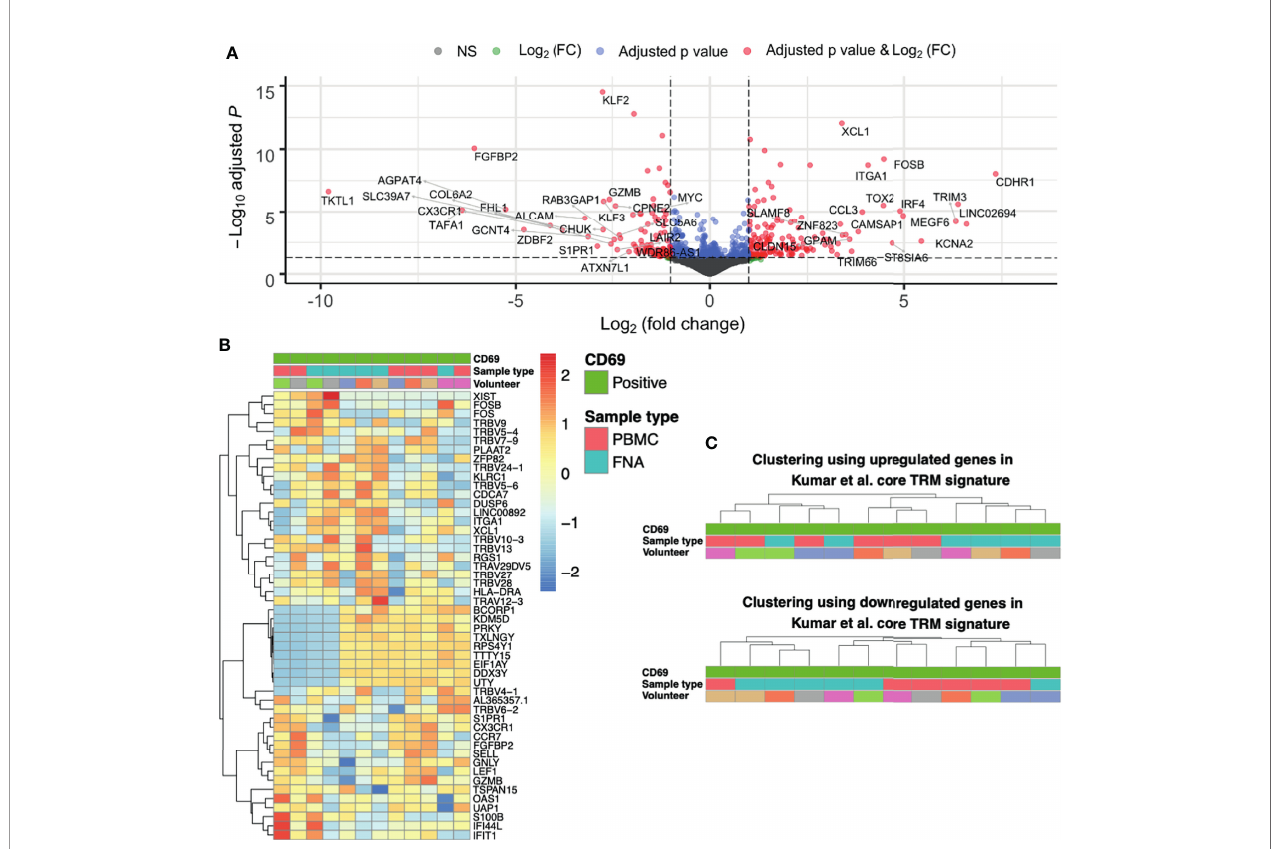
FIGURE 3 | The differences between CD69+ CD8+ T cells isolated from liver and blood are unique and not like those when comparing TRM and TEM cells. (A) Volcano plot of up- and down-regulated genes between paired FNA CD69+ and PBMC CD69+ samples. The top 50 up- and down-regulated genes have been annotated. Positive log(FC) values indicate greater gene expression in FNA CD69+ samples, compared to PBMC CD69+ samples. Negative log(FC) values indicate greater gene expression in PBMC CD69+ samples. DGE of 11,933 genes was tested for signi fi cance using the Wald test. P values were adjusted using the Benjamini-Hochberg correction (false discovery rate). (B) Heatmap of the most variable genes in the FNA CD69+ vs PBMC CD69+ comparison. Fifty most variable genes between FNA CD69+ and PBMC CD69+ samples. Yellow/red corresponds to increased counts compared to other samples and blue corresponds to decreased counts. Genes selected according to those with the greatest variance across samples. Columns are clustered based on Spearman ’ s correlation of rlog normalised count values. Rows are clustered according to Pearson correlation of the rlog normalised gene counts. Gene count values are centred and scaled across rows. (C) Clustering of FNA and PBMC CD69+ samples using expression of TRM cell genes. Hierarchical clustering trees based on Spearman ’ s correlation of sample rlog normalised count values considering up- and down-regulated genes in CD8+ Kumar et al. core TRM cell transcriptional signature. FC, fold change; FNA, fi ne needle aspirate; PBMC, peripheral blood mononuclear cells; rlog, regularised logarithm; TRM, tissue-resident memory T